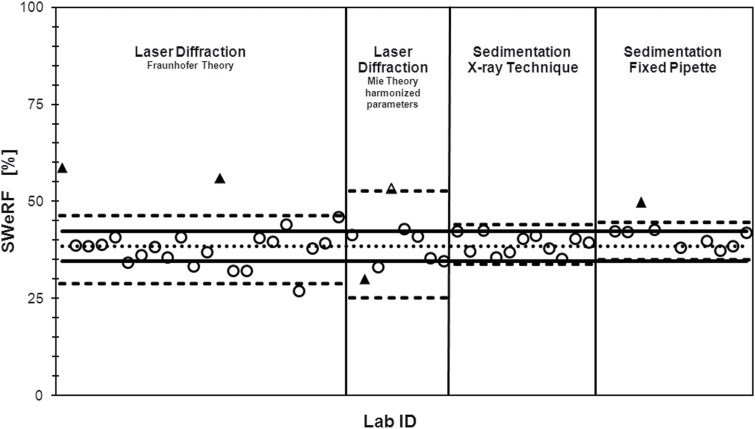
Reproducibility of SWeRF measurements with different techniques. Dotted line: target value; dashed line: statistic tolerance limits of the method; solid line: tolerance around mean value with 10% standard deviation; and triangles: statistical outliers according to Dixon (DIN 53804-1; Deutsches Institut für Normung e.V. (German National Standard), 2002).